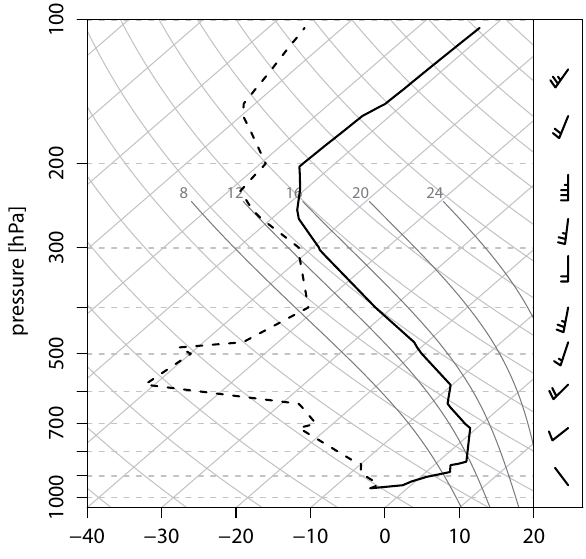
Fig. 5. Skew-T Log-P diagram of the atmospheric sounding taken at Innsbruck airport on 19 November 2011, 03:00 UTC. Solid line: temperature, dashed line: dew point temperature, wind barbs and wind arrows: wind speed and direction,